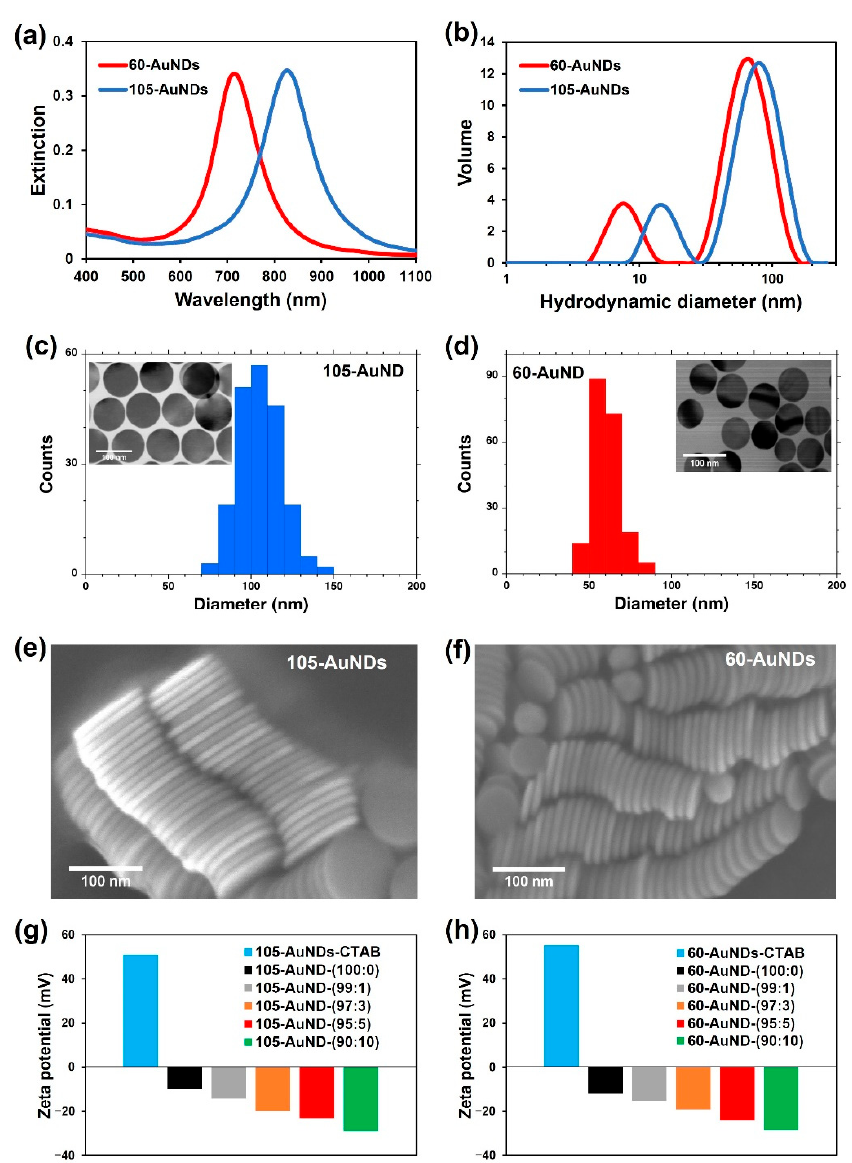
Figure 1. Characterization of the synthesized AuNDs: ( a ) the extinction spectra of CTAB-stabilized AuNDs; ( b ) size distribution of AuNDs determined by DLS, with the 105- and 60-AuNDs shown by blue and red, respectively, in ( a , b ); ( c ) TEM image and size distribution of 105-AuNDs and ( d ) 60- AuNDs obtained by STEM; ( e ) SEM image of 105-AuNDs and ( f ) 60-AuNDs dried on the silicone substrate; ( g ) the zeta potentials of 105-AuNDs and ( h ) 60-AuNDs stabilized with CTAB (blue) and modified with a ligand mixture C1:COOH (100:00) (black), (99:1) (grey), (97:3) (orange), (95:5) (red), and (90:10) (green).